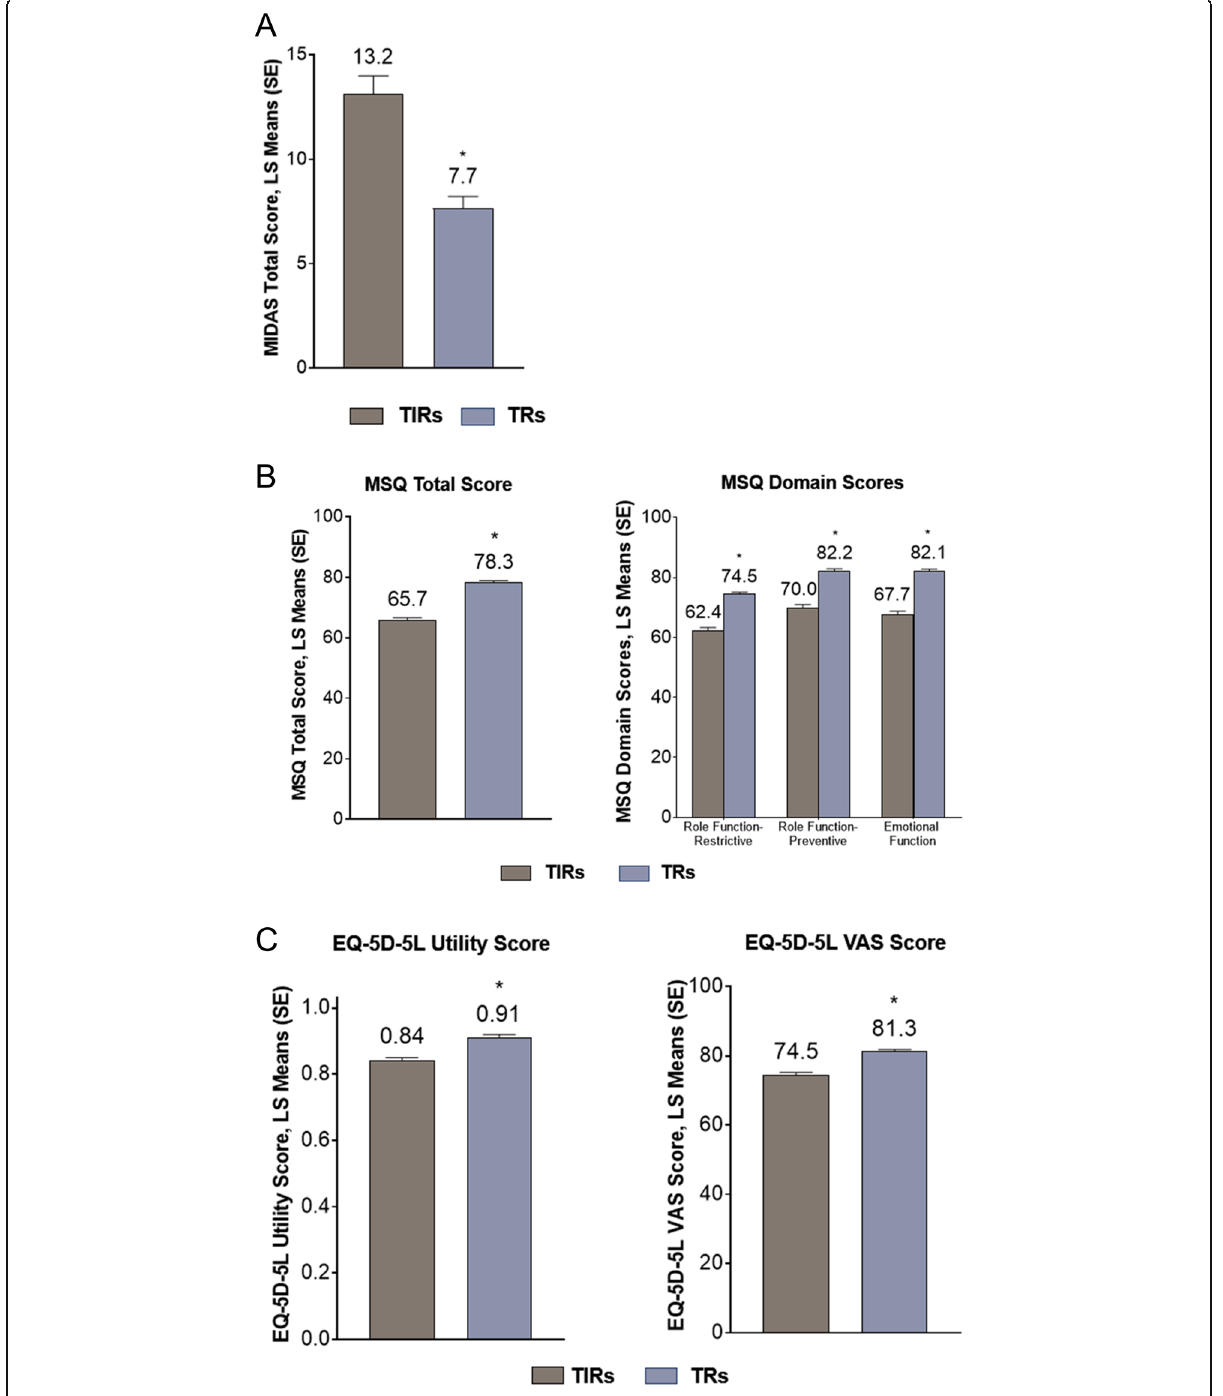
Fig. 3 Patient-reported outcomes in patients with migraine receiving treatment for acute migraine: a MIDAS; b MSQ; and c EQ-5D-5L scores according to response to triptan medication. Data were controlled for age, sex, migraine headache day frequency, comorbidities, duration of illness, preventive medication use, and presence of aura. * p <0.001 for TIRs versus TRs using multivariable general linear model controlling for age, sex, migraine headache day frequency, comorbidities, duration of illness, preventive medication use, and migraine with or without aura. Note: Higher MIDAS score indicates greater disability; lower MSQ score indicates lower HRQoL; lower EQ-5D-5L score indicates lower HRQoL. EQ-5D-5L=EuroQol 5- Dimensions 5-Levels questionnaire; HRQoL=health-related quality of life; LS=least squares; MIDAS=Migraine Disability Assessment; MSQ=Migraine- Specific Quality of Life Questionnaire; SE=standard error; TIR=triptan insufficient responder; TR=triptan responder, VAS=visual analog